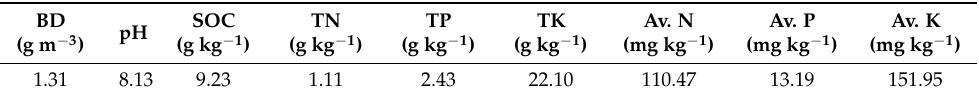
Table 1. The physicochemical properties of 0–20 cm soil at the beginning of the experiment in 2008